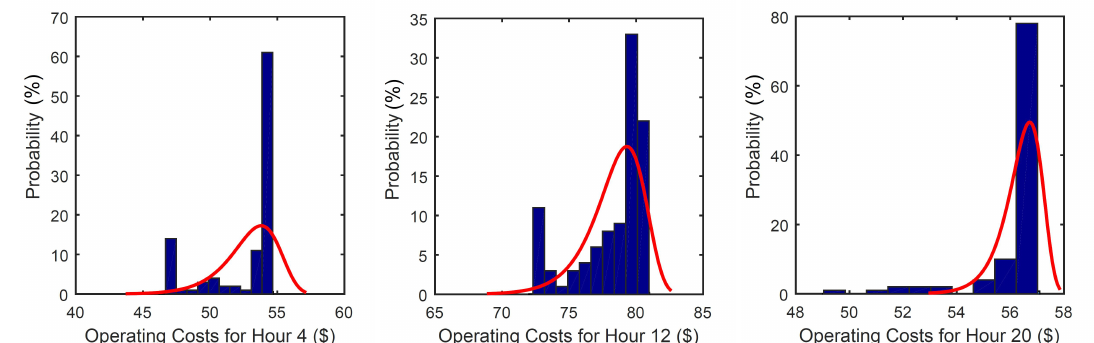
Figure 9. Probability of the operating cost on the 4th hour ( left ), 12th hour ( center ), and 20th hour ( right ) of the 20 March case study.